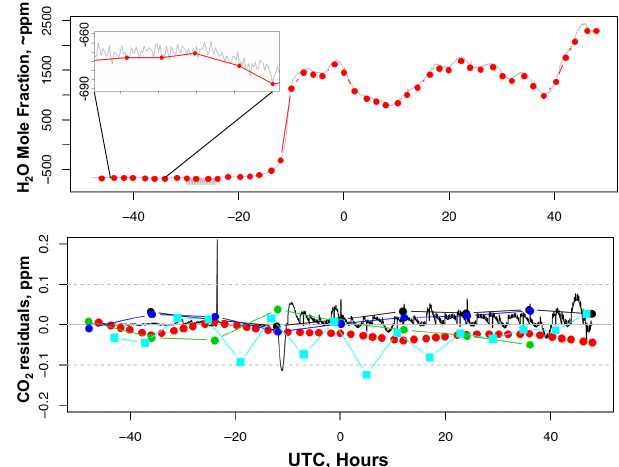
Fig. 7. (a) χ H reported by the Li-7000 at the SNP site for 2 O 13–15 February 2010, when the Nafion dryer counterflow was lost. Red symbols correspond to baseline calibration measurements. (b) The corresponding values of δ wv (black curve) along with the CO 2 calibration and target residuals (CO2C1 = black circles, CO2C2 = red circles, CO2C3 = green circles, CO2C4 = blue cir- cles, CO2TGT = cyan squares). Negative χ H values result from 2 O inaccurate (manufacturer-specified) zero-offset values for the Li- 7000, but relative changes can be interpreted with some